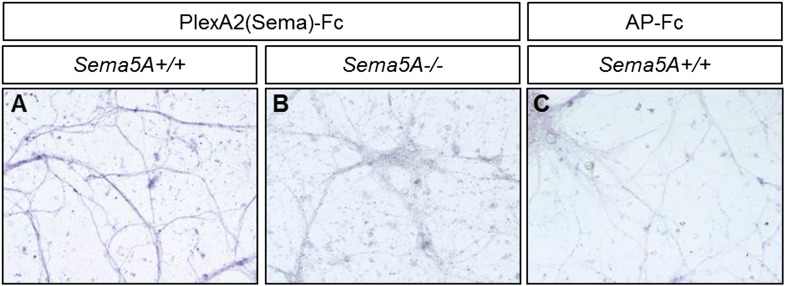
Sema5A can be detected on the neuronal surface and is localized to neurites.(A–C) Visualization of endogenously expressed Sema5A on the surface of DIV14 dissociated dentate gyrus cultures. (A) PlexA2Sema-Fc strongly binds to Sema5A+/+ cultures (B) but not to Sema5A−/− cultures. (C) AP-Fc binding to Sema5A+/+ cultures was used as a control.